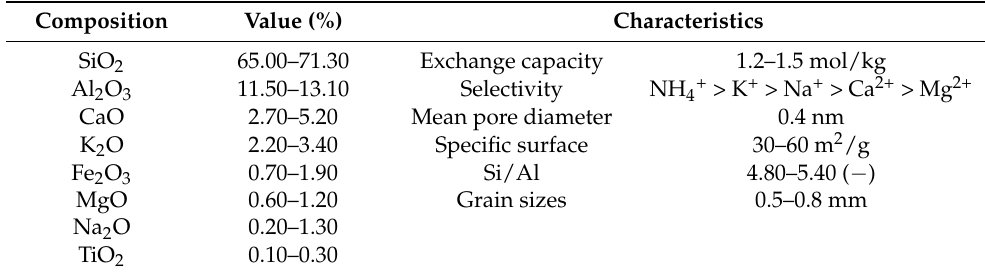
Table 2. Chemical composition and zeolite characteristics, data provided by supplier.